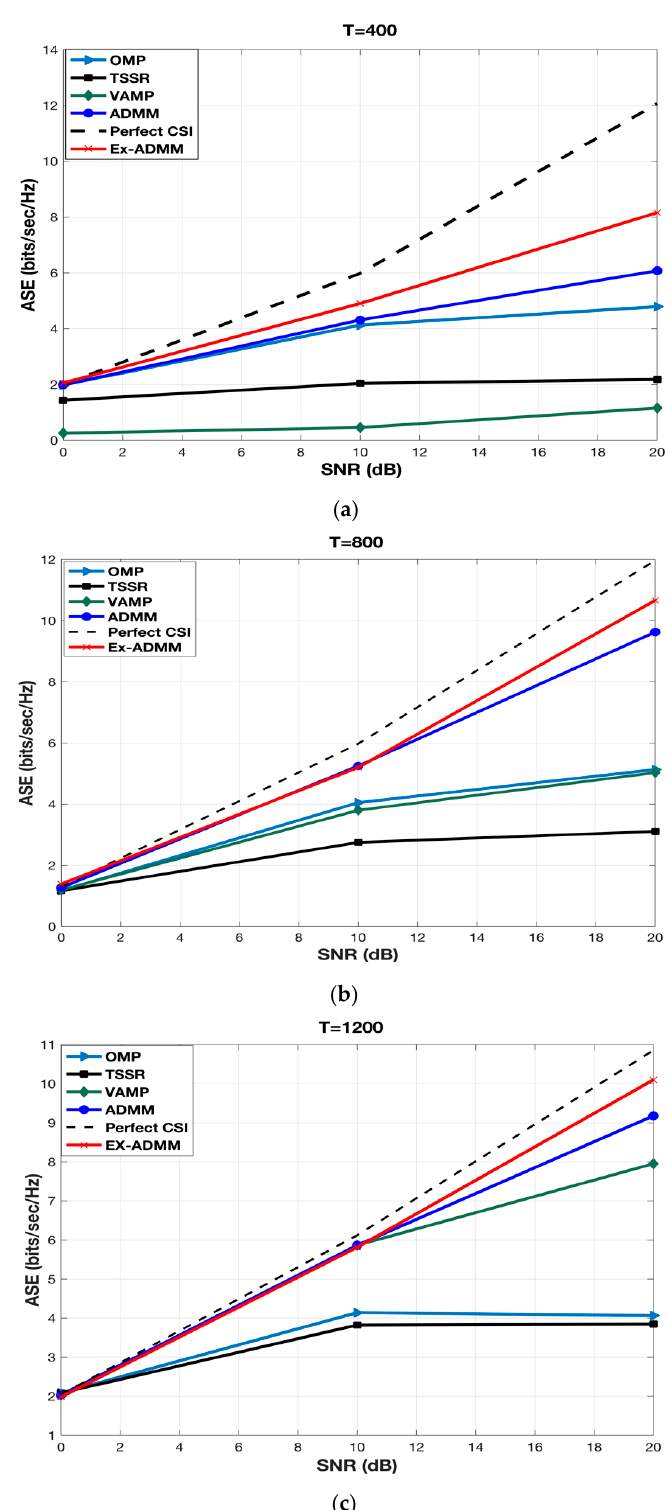
Figure 2. ( a – c ) ASE for different transmit SNRs for a 64 × 64 mmWave MIMO channel at T = 400, T = 800 and T = 1200.